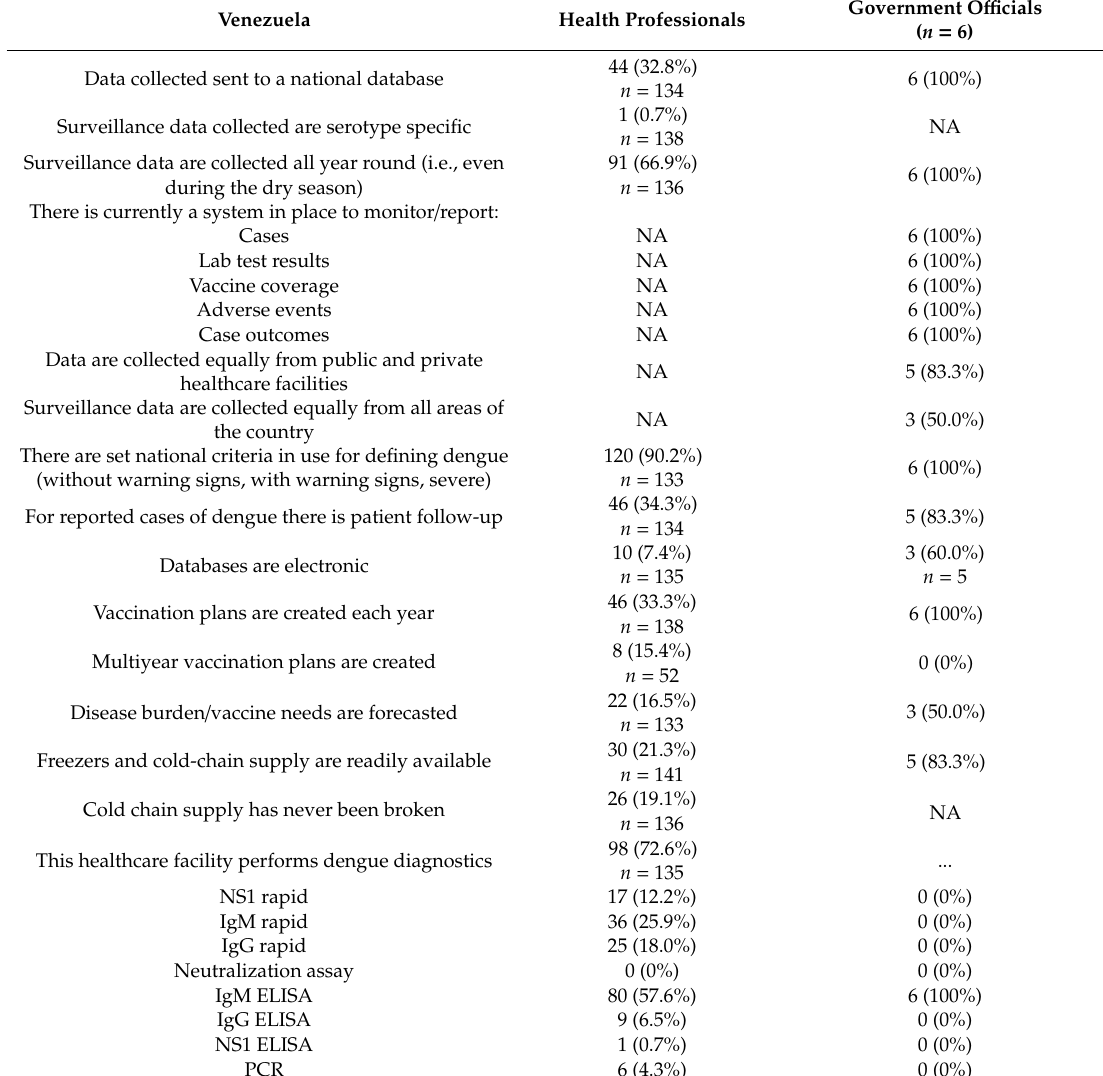
Table 5. Logistical preparedness. Percentage of respondents who answered “yes” to the following statements regarding surveillance data collection, current vaccination programs, and dengue